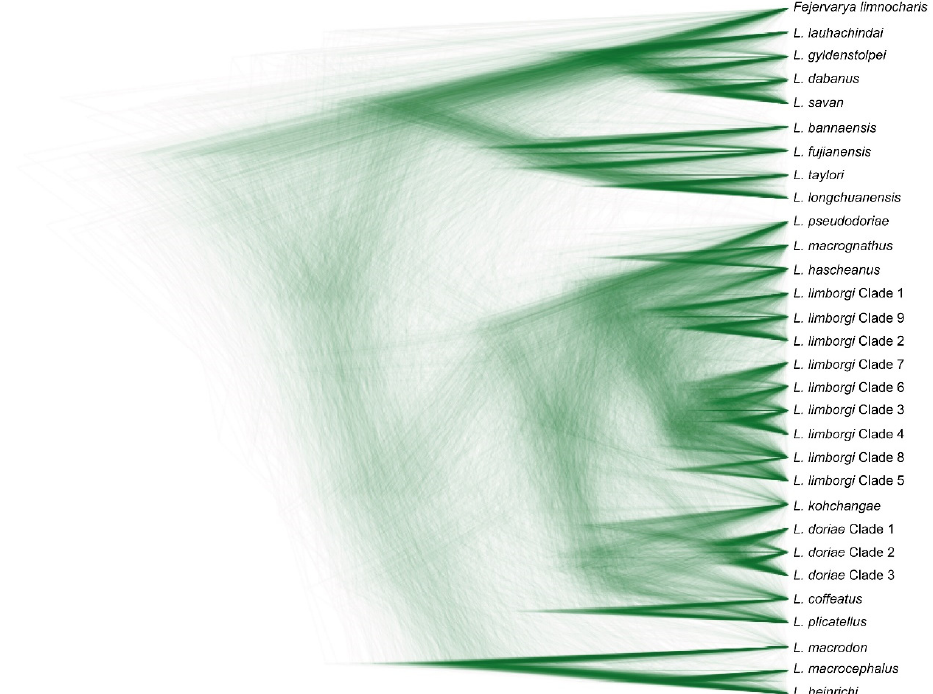
Figure 2. Species tree indicating phylogenetic relationships among frogs of the genus Limnonectes from a BEAST analysis showing density of trees proportional to frequency of occurrence drawn in DensiTree.